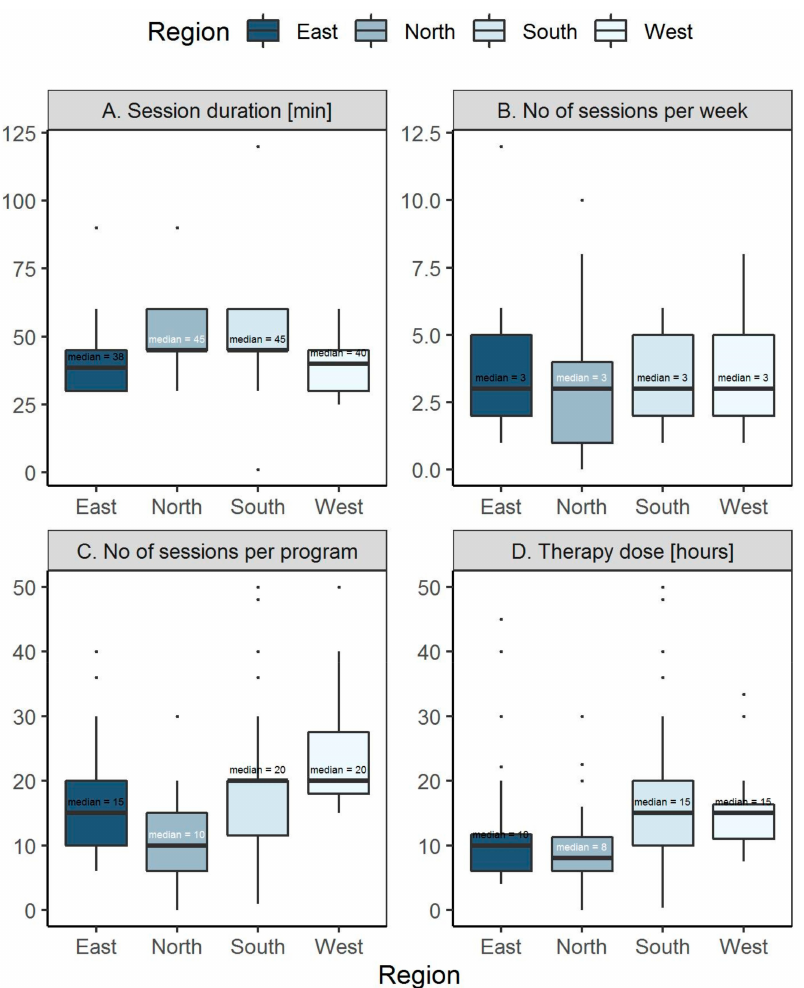
Figure 3. Characteristics of therapy session by regions. ( A ). Session duration. ( B ). Number of sessions per week. ( C ). Number of sessions per program. ( D ). Therapy dose